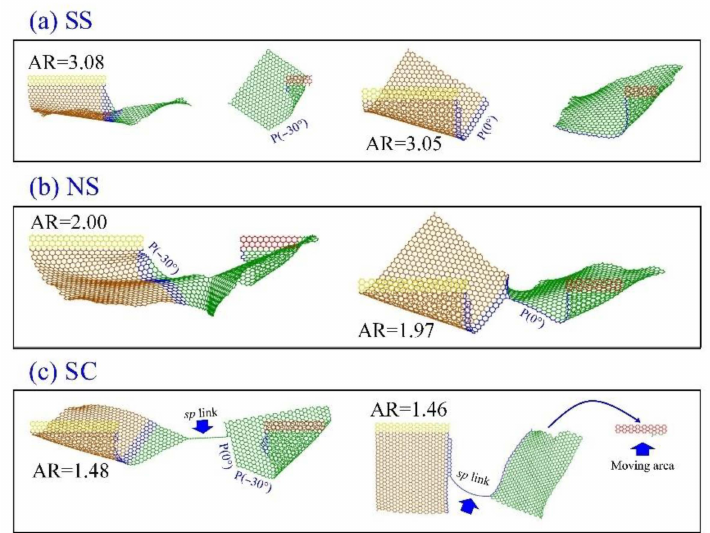
Figure 6. Propagation styles of the cracks in sheets under an in-plane tearing at 1 K: ( a ) “SS” for split with smooth edges at v = 0.6 Å/ps, ( b ) “NS” for not split off when v = 0.2 Å/ps, and ( c ) “SC” for split but still connected via an sp carbon link when v = 1.0 Å/ps. In each of the three panels, the left-hand sheet is the In-AC3 and the right-hand one is the In-ZZ3.